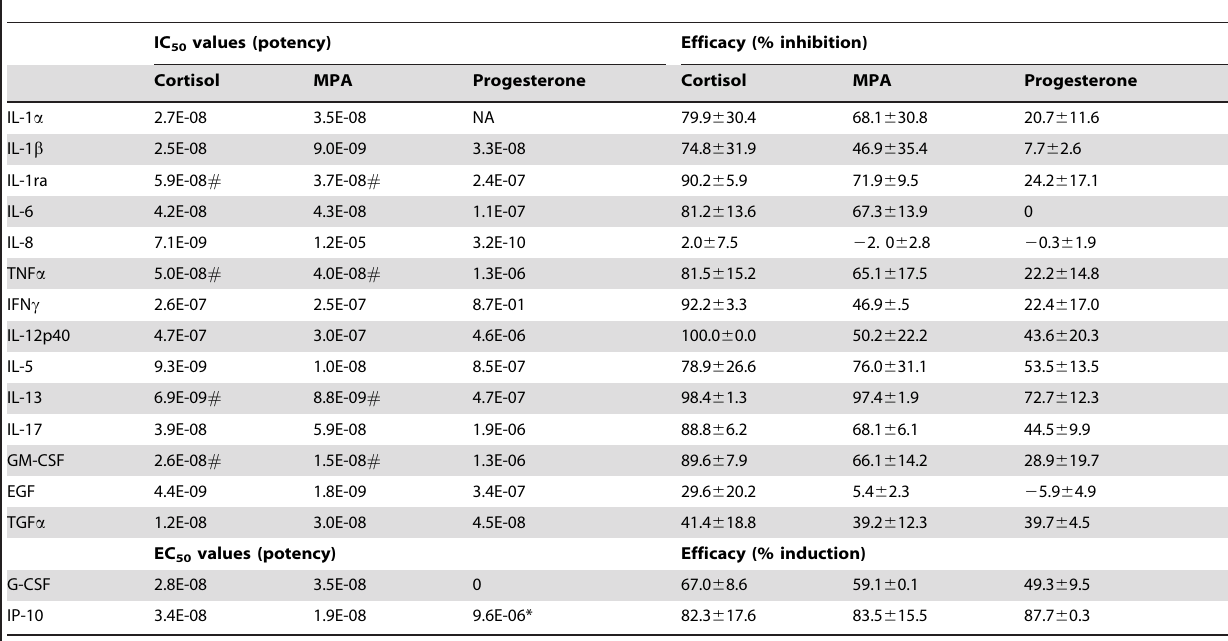
Table 2. Potency and efficacy of cortisol, MPA and progesterone as determined by the dose response curves.